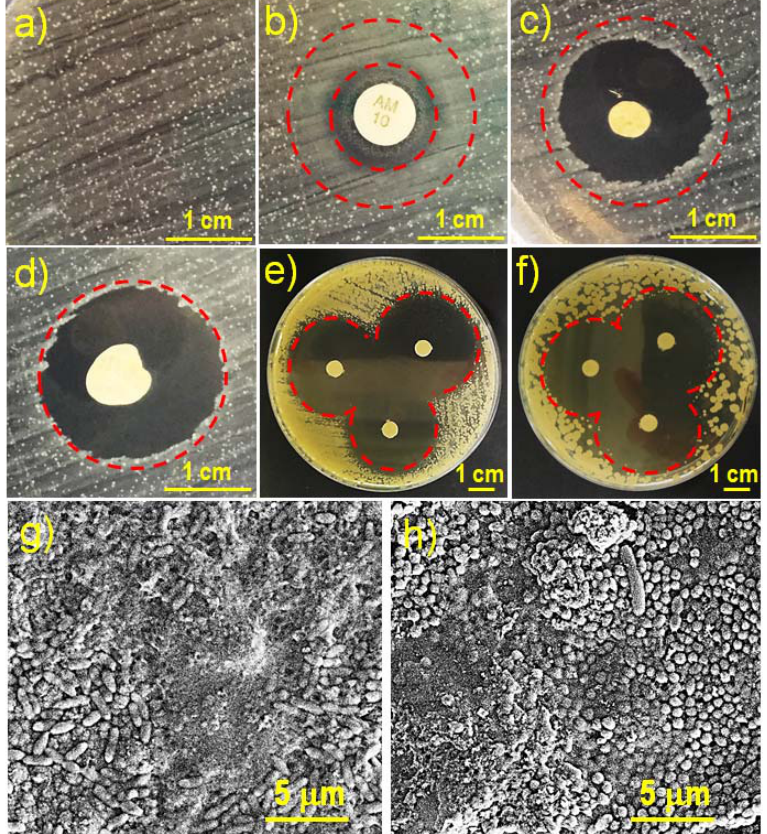
Figure 11. Inhibition of bacterial growth. Growth of the Staphylococcus aureus Gram ‐ positive bacteria on a LB agar plate, control ( a ), bactericide effect (inner circle) and bacteriostatic effect (outer circle) of the ampicillin antibiotic ( b ), and bactericide activity of the hydrogels having a theoretical crosslinking degree of 50% and loaded with CHX and ( c ) and PHMB ( d ). For comparison, the outer circle is drawn the same size in ( b – d ). Inhibition of antimicrobial solution containing 6.2 w / v ‐ % of CHX ( e ) and 1.5 w / v ‐ % of PHMB ( f ). SEM images of the bacteria E. coli ( g ) and S. aureus ( h ) forming bio ‐ films on the surface of the hydrogel.